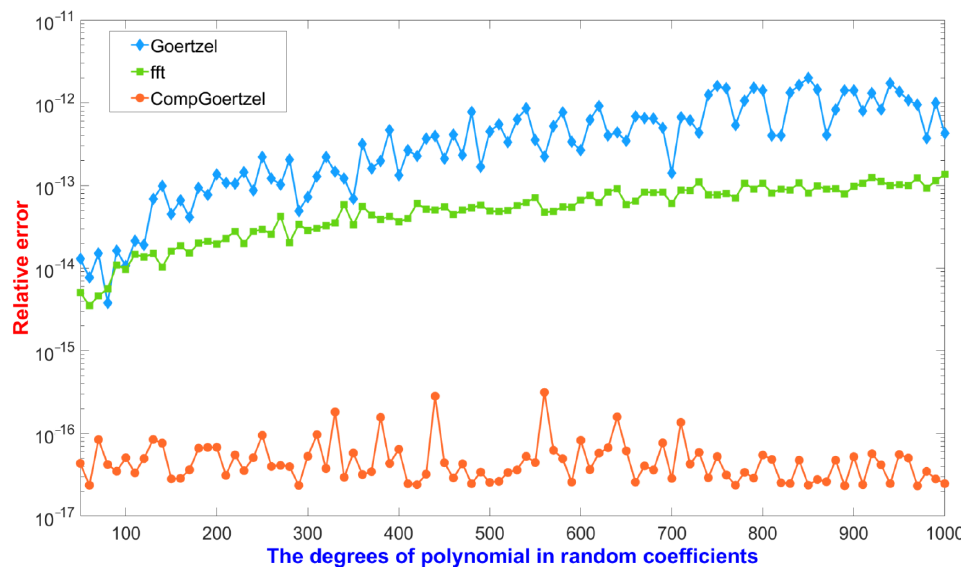
Figure 4. The relative errors of DFT for polynomials with random